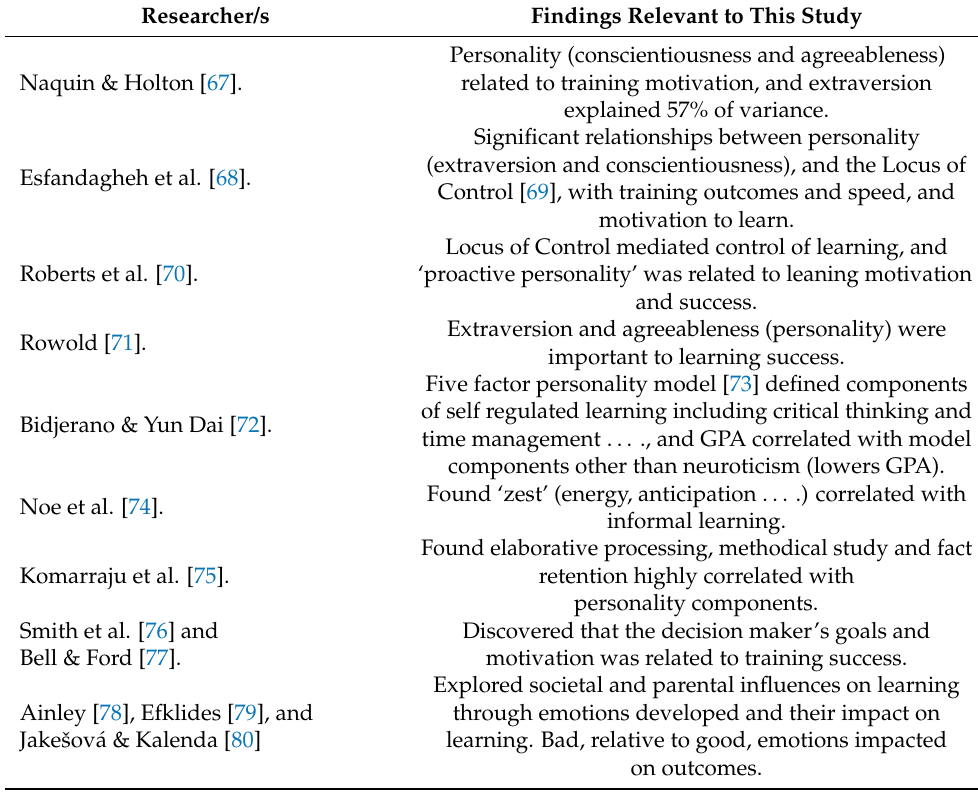
Table 3. Examples of research of phenotypic and other influences on